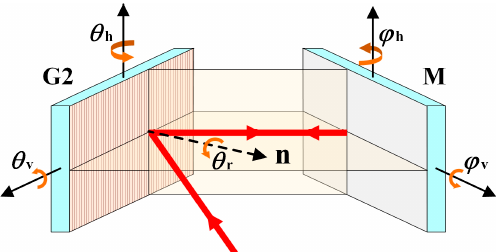
Figure 2. The schematic diagram of the five misalignments of the grating and mirror in the stretcher. G2, the second grating in grating pair stretcher; n , the normal direction of G2; θ h , the tilt angle error of grating G2 in the horizontal direction; θ v , the tilt angle error of grating G2 in the vertical direction; θ r , the rotation angle error of grating G2 that can lead to unparallel grooves of the grating pair; φ h , the tilt angle error of mirror M in the horizontal direction; φ v , the tilt angle error of mirror M in the horizontal direction. The arrows denote the positive direction.